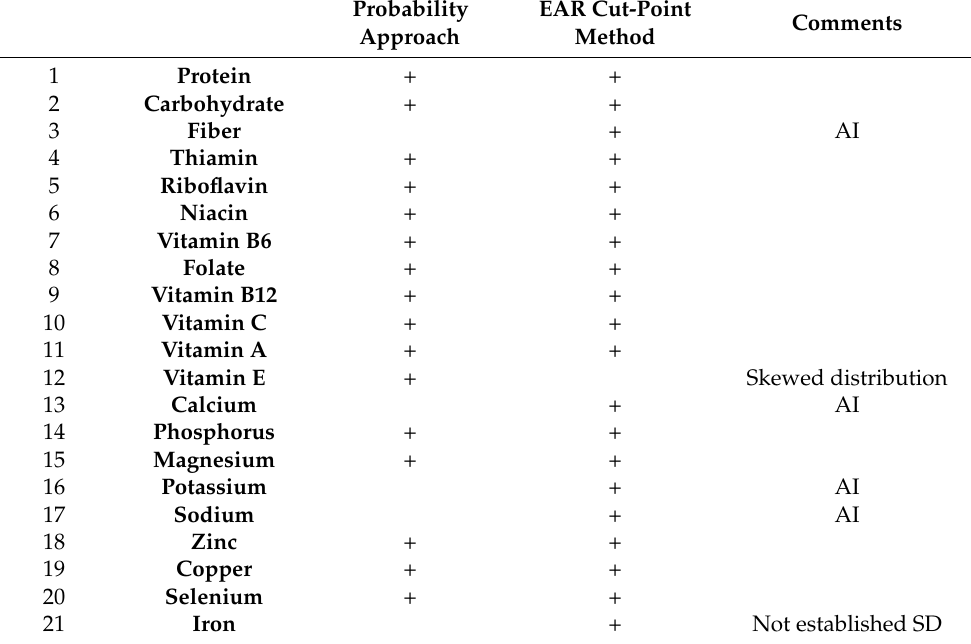
Table 1. Applied methods for estimating the nutrient inadequacy for the macro- and micronutrients under